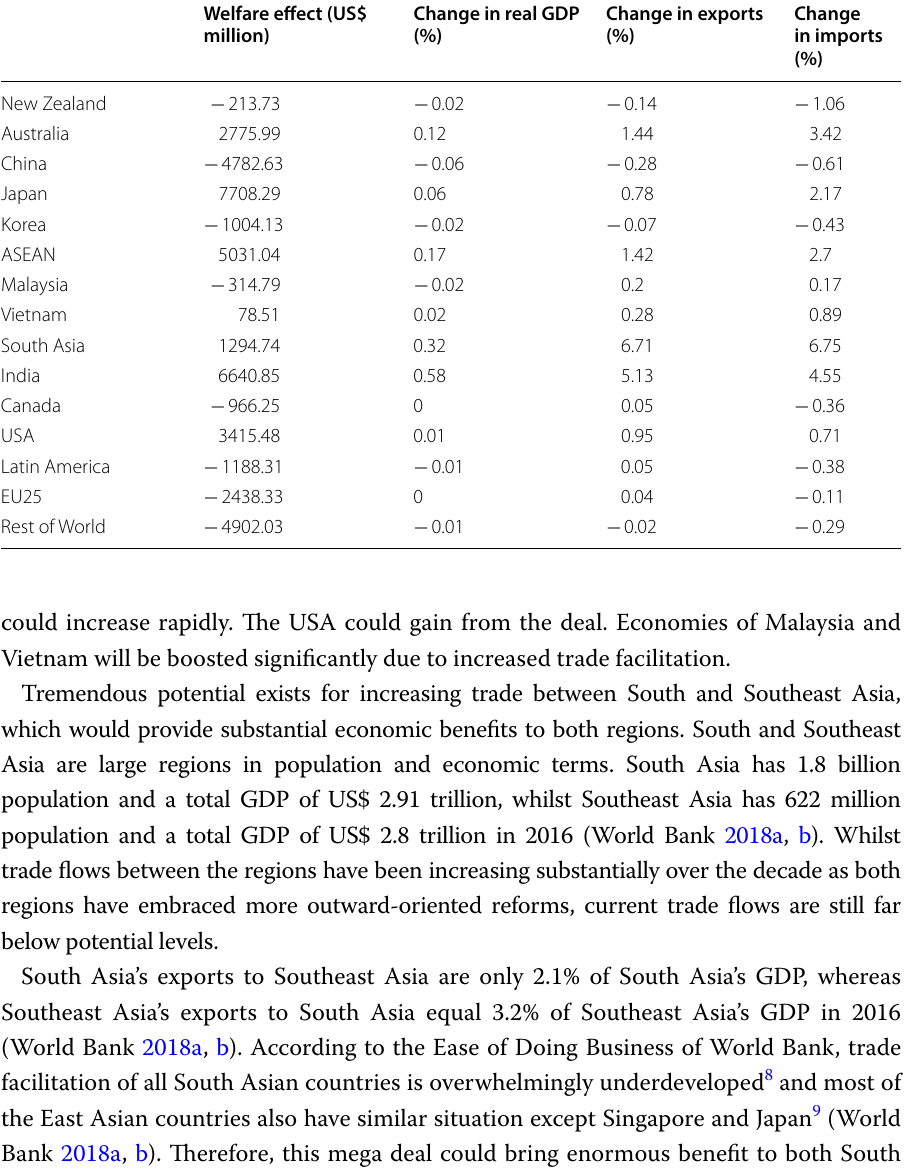
Table 6 Macroeconomic impact of tariff eliminations under ‘Indo-Pacific 2: Indo-Pacific 1 Rest of South Asia Rest of ASEAN’. Source: Authors’ simulation from GTAP version + +